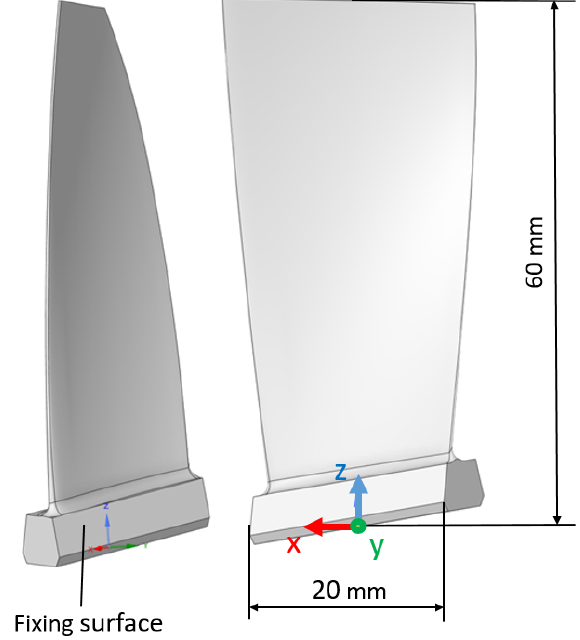
Figure 1. Geometrical model of the compressor blade of the first stage of the PZL-10W engine.